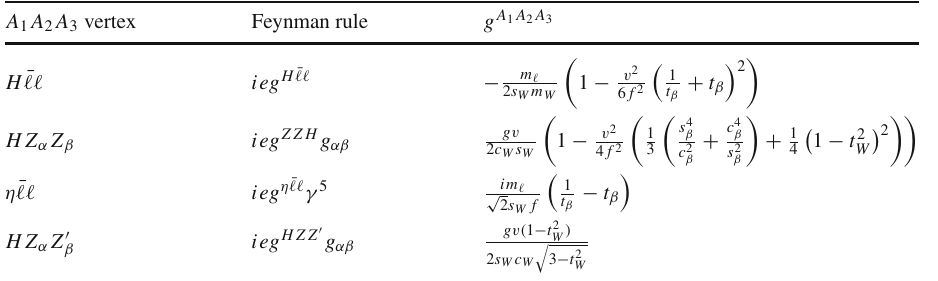
Table 5 Feynman rules for the vertices involving the scalar bosons H and η at the leading order in v/ f in the SLHM